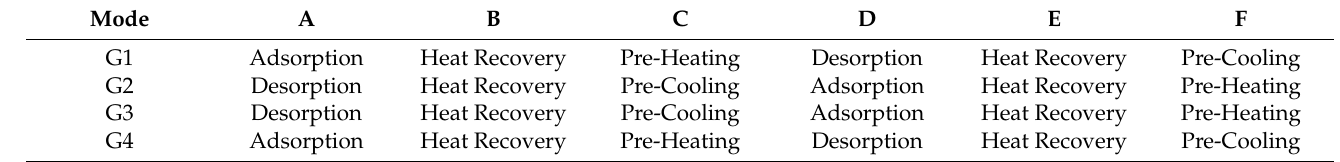
Table 1. Operation modes for the two-stage chiller with mass and heat